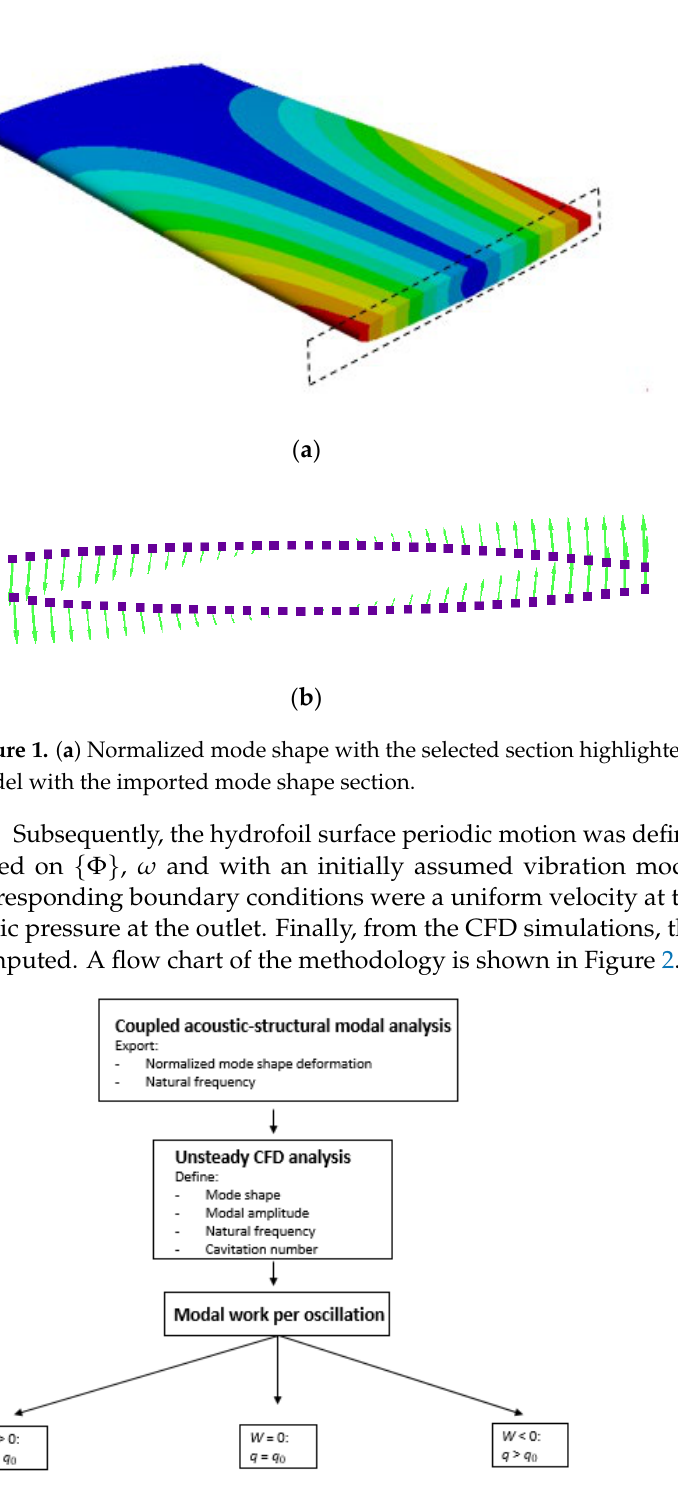
Figure 2. Modal work computation flow chart.